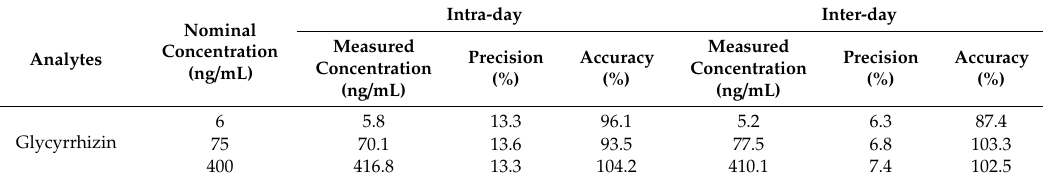
Table 3. Intra- and inter-day precision and accuracy of glycyrrhizin, isoliquiritigenin, liquiritin and